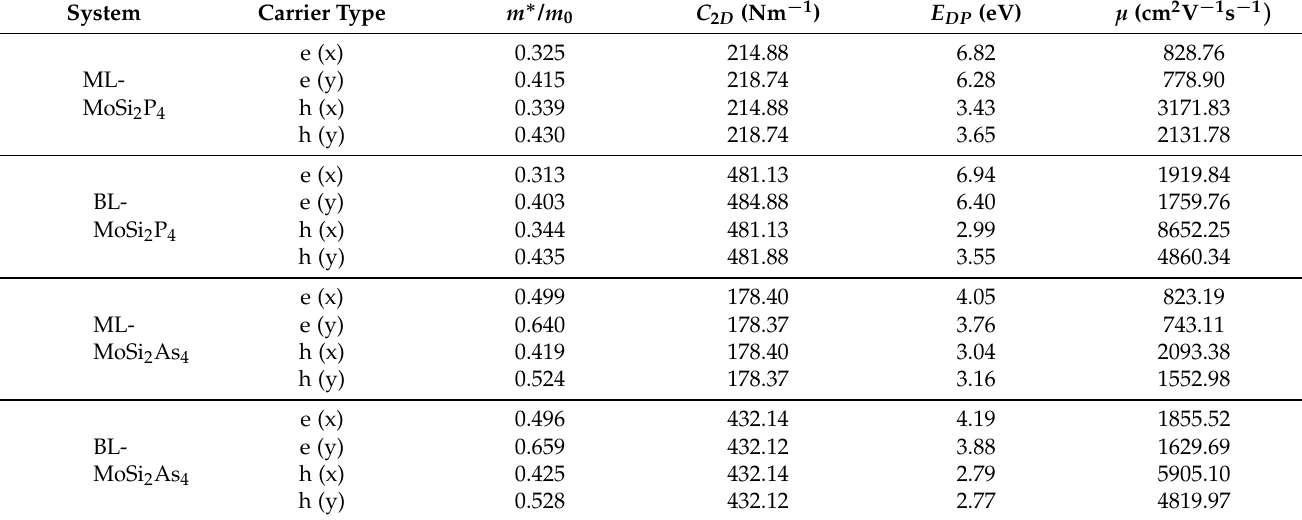
Table 3. The effective mass m ∗ , elastic modulus C 2 D , deformation potential constant E DP , and carrier mobility µ along x and y directions for monolayer and bilayer MoSi 2 Z 4 at 300